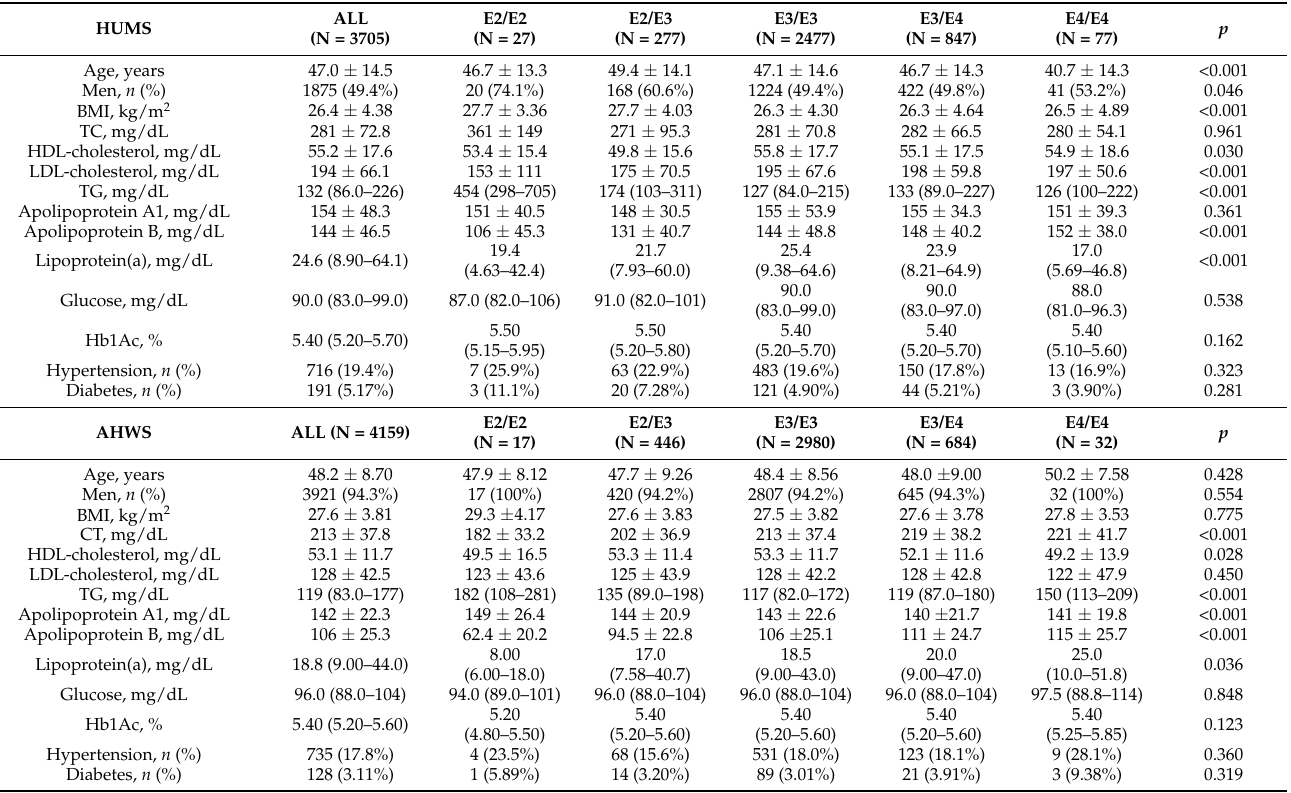
Table 2. Clinical and biochemical characteristics according to APOE genotype in both